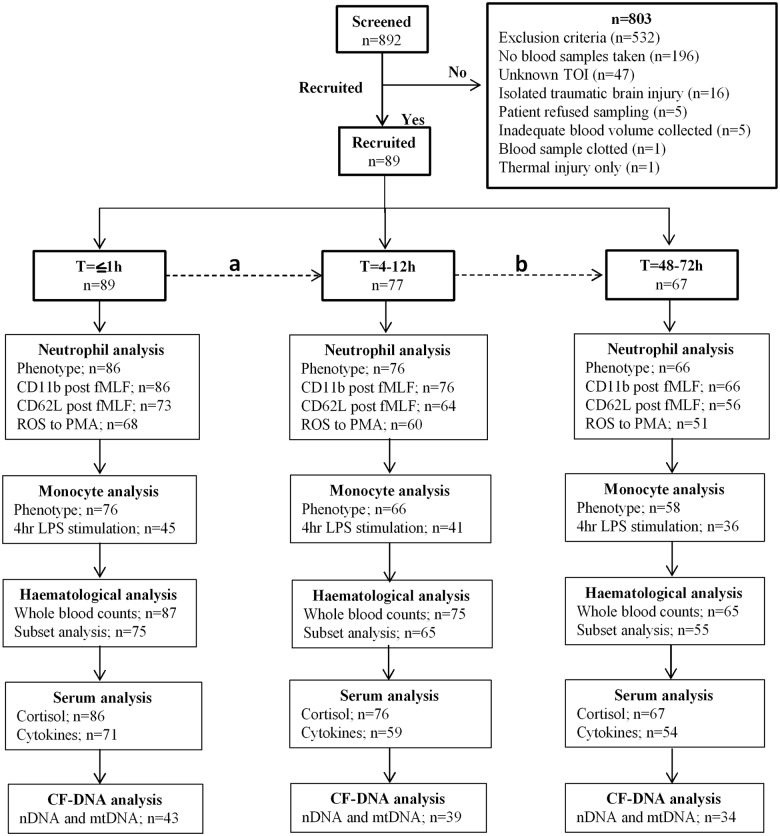
Flow diagram showing recruitment and analysis of study subjects.(A) A total of 12 patients were lost between the T≤1-hour and T = 4–12-hour time points as a result of steroid treatment (n = 4), refusal of sampling (n = 6), hospital discharge (n = 1), and mortality (n = 1). (B) Patients lost as a result of mortality (n = 2), difficulty in bleeding (n = 3), refusal of sampling (n = 5), hospital discharge (n = 2), and steroid treatment (n = 1). Three patients who refused blood sampling at the T = 4–12-hour time point provided samples at the T = 48–72-hour time point. Thus, a total of 10 patients were lost between the T = 4–12-hour and T = 48–72-hour time points. Insufficient sample volume and equipment breakdown account for the differences in patient numbers between each parameter analysed. CF-DNA, cell-free DNA; fMLF, formyl-methionine-leucine-phenylalanine; LPS, lipopolysaccharide; mtDNA, mitochondrial DNA; nDNA, nuclear DNA; PMA, phorbol 12-myristate 13-acetate; ROS, reactive oxygen species; TOI, time of injury.